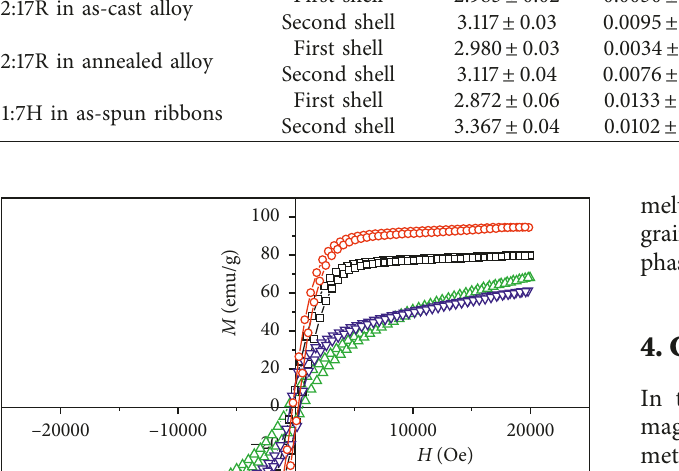
R 10 alloys with different states. 0 , calculated from the fractional coordinates of .” ±